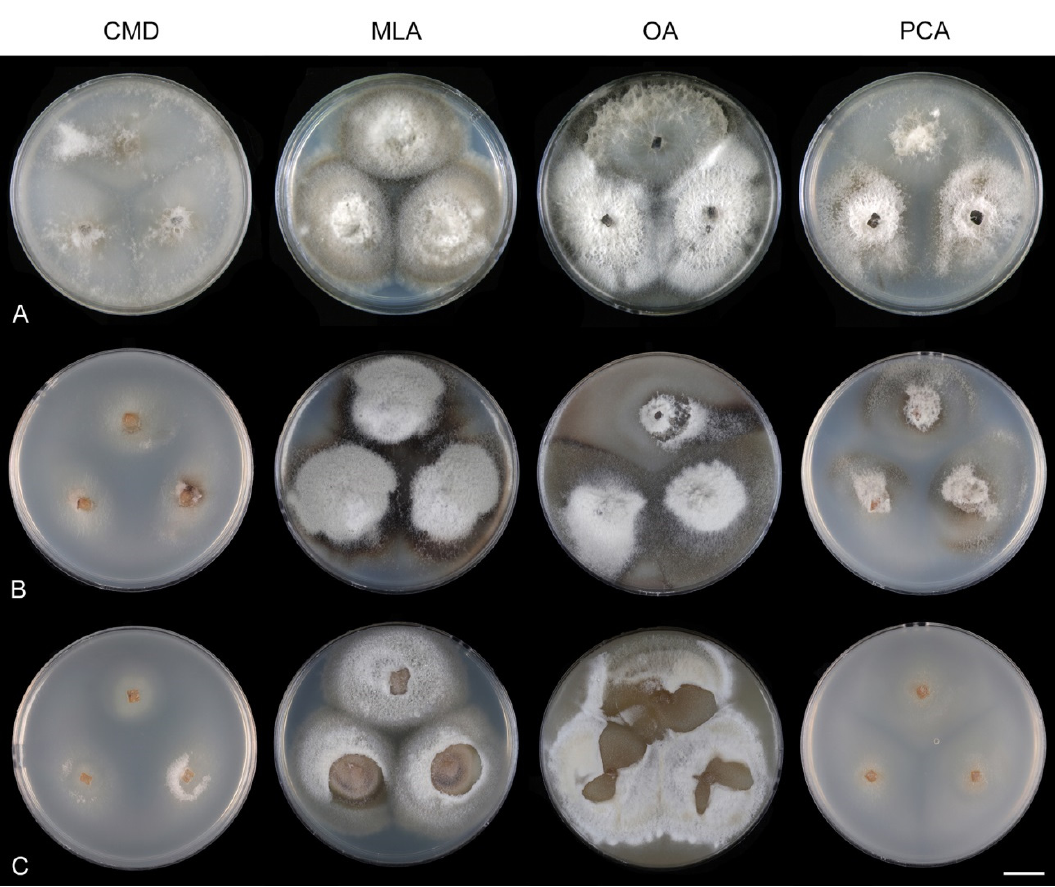
Figure 18. Colony morphology of Codinaea paniculata after 4 weeks. ( A ) CBS 145098 ex-type ( B ) CBS 127692 ( C ) MUCL 34876. Scale bar: ( A – C ) 1 cm.